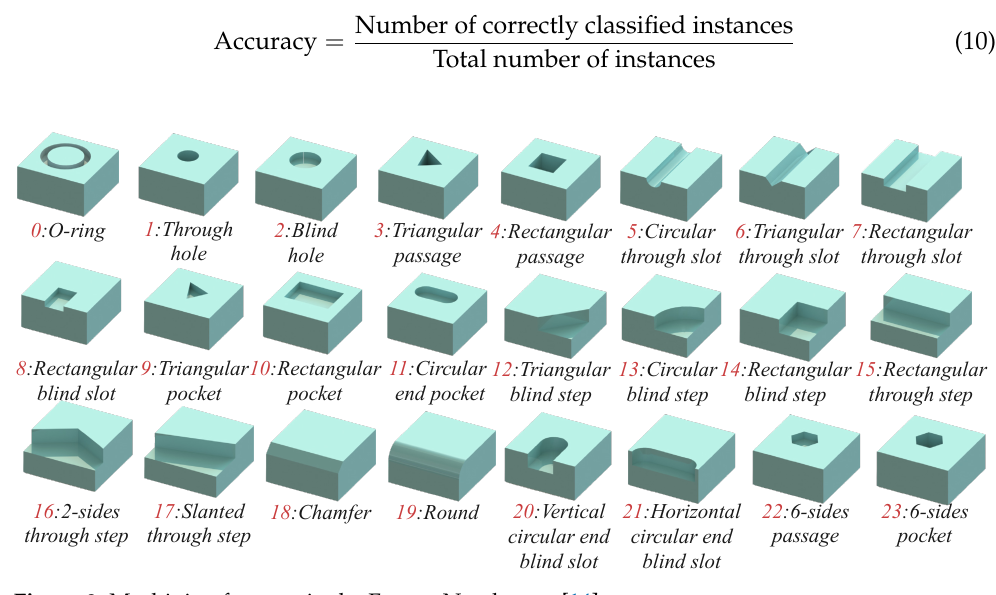
Figure 8. Machining features in the FeatureNet dataset